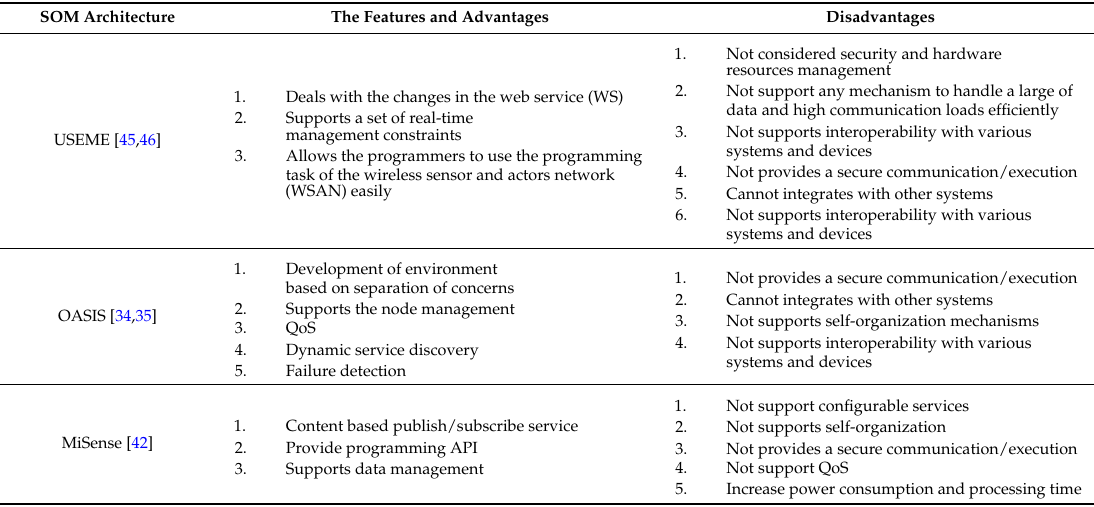
Table 3. Advantages and Disadvantages of SOM Architectures for